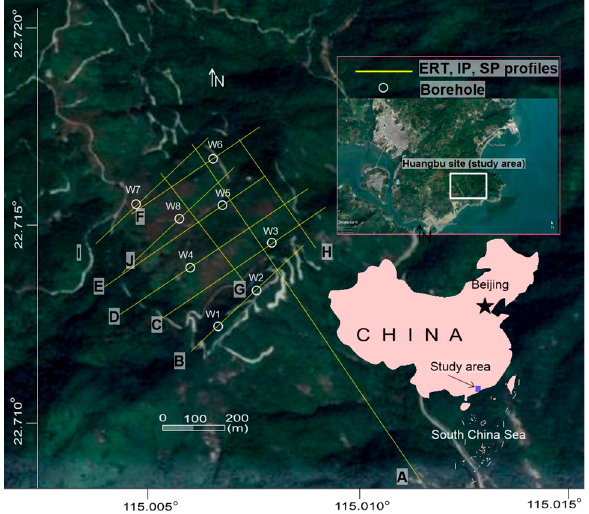
Figure 1. Location of the investigated area including the geophysical profiles (yellow lines) of ERT, IP and SP measurements, and boreholes (white circles). IP and SP measurements, and boreholes (white